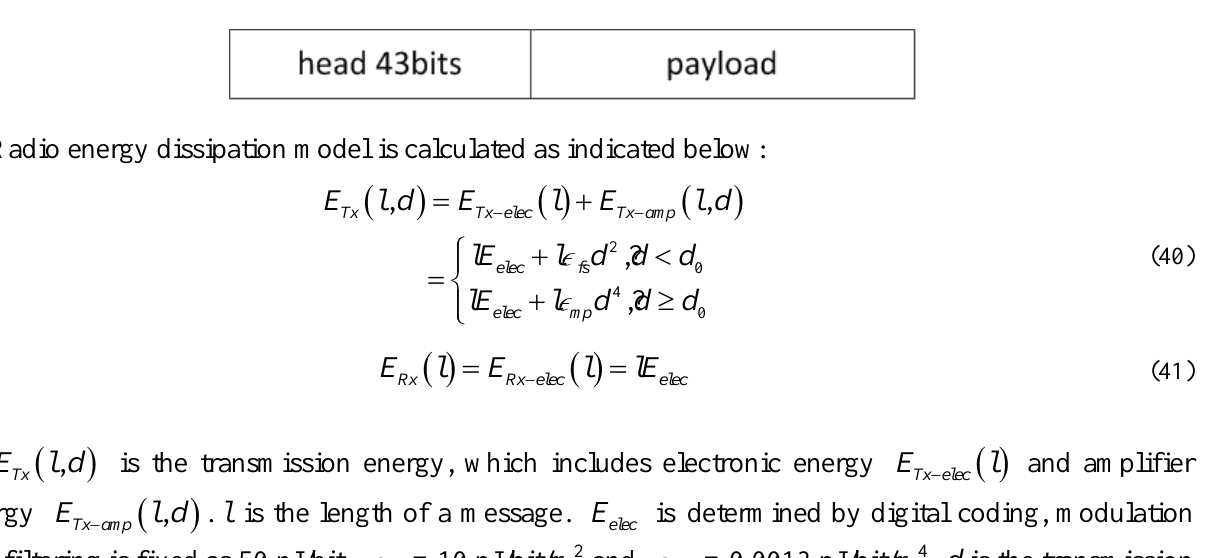
Figure 11. Brief frame structure of